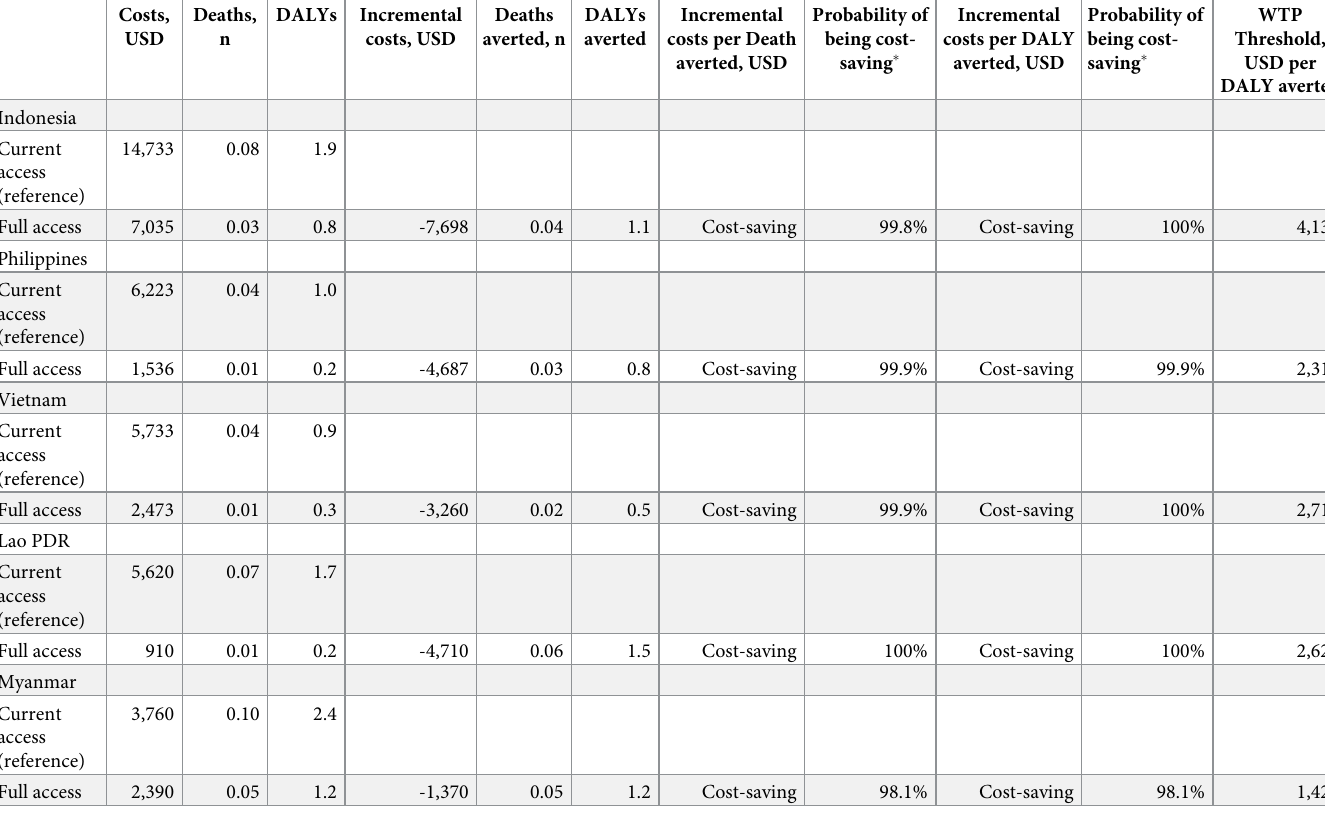
Table 2. Cost-effectiveness of improving access to snake antivenom in ASEAN countries. Costs, Deaths, USD